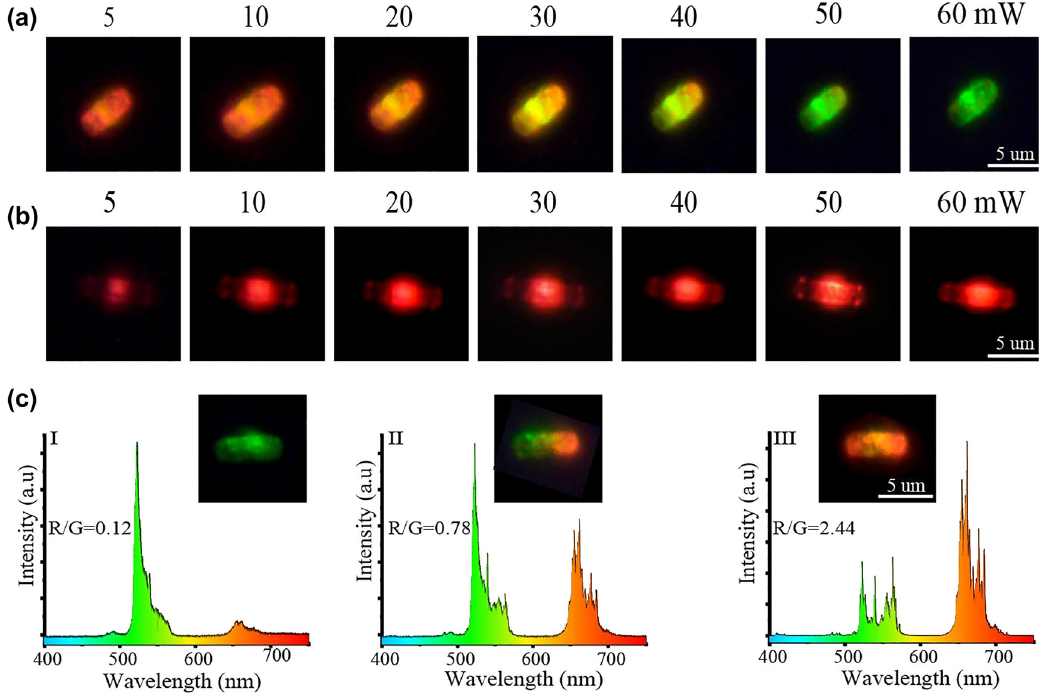
Figure 5: Luminescence emission patterns and spectra for the Y 2 O 3 :Er 3 + /Yb 3 + with and without optical heater. (a) Luminescence patterns of a single Y 2 O 3 :Er 3 + /Yb 3 + microrod coated with optical heaters and measured at different excitation powers; (b) luminescence patterns of a single bare Y 2 O 3 :Er 3 + /Yb 3 + microrod, measured at different excitation powers; (c) UCL pattern and emission spectra of a Y 2 O 3 :Er 3 + /Yb 3 + microrod coated with Ag NIs, excited at the center (I) end (II) and (III) side edge of the